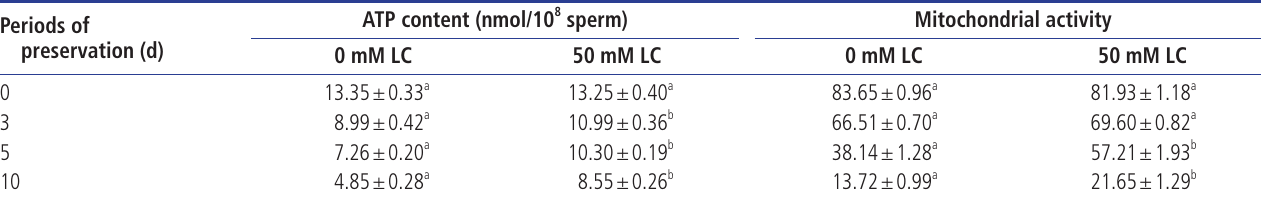
Table 4. Effects of L-carnitine on boar sperm ATP content and mitochondrial activity during preservation Periods of preservation